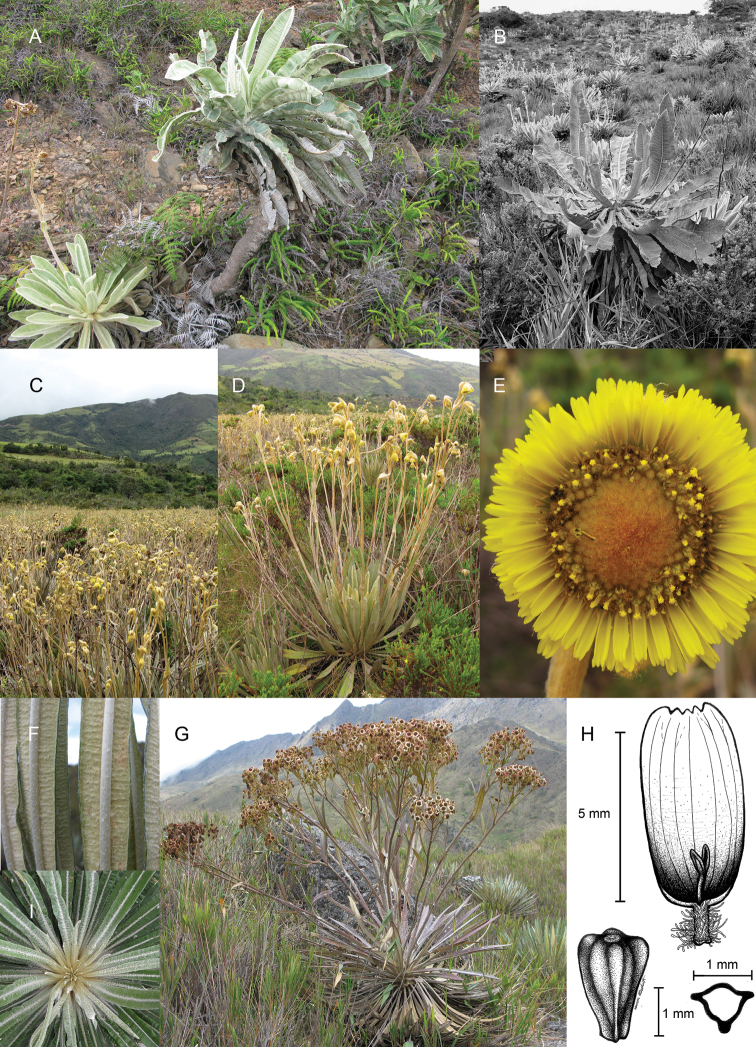
A–B
Espeletiopsis ×cristalinensis in the topolocality (A coll. M.Diazgranados 4088 (center), growing between Espeletia aristeguietana (bottom left corner) and Libanothamnus neriifolius (top right corner) B coll. J.Cuatrecasas 28994) C-E first record of Espeletia steyermarkii for Colombia (coll. M.Diazgranados 3862) F–I first record of Ruilopezia cardonae for Colombia (coll. M.Diazgranados & R.Sánchez 3922). Photographs A, C–G, I by M.Diazgranados, B by J.Cuatrecasas; illustrations in H by Lauren Merchant.